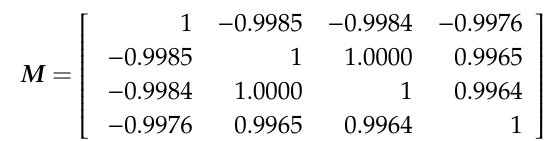
Figure 12. TZSCs for SPG fault (Case 2). ( a ) Lian L 1 ; ( b ) Lian L 2 ; ( c ) Lian L 3 ; ( d ) Lian L 4 .